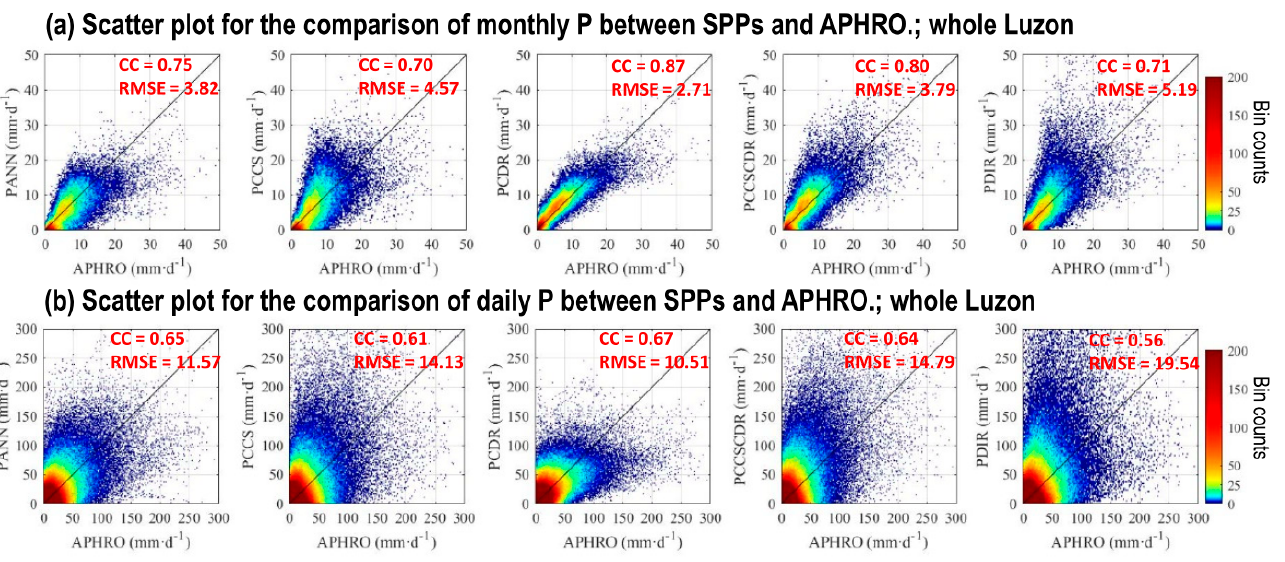
Figure 7. ( a ) The scatter plot for the comparison of monthly precipitation between the APHRO and the SPPs from 2003–2015. In ( a ), the spatial grids (0.25° × 0.25°) over the entire Luzon region are used for comparison. The values of CC and RMSE between the APHRO and the SPPs are added in each panel; and ( b ) as in ( a ), but for daily precipitation.